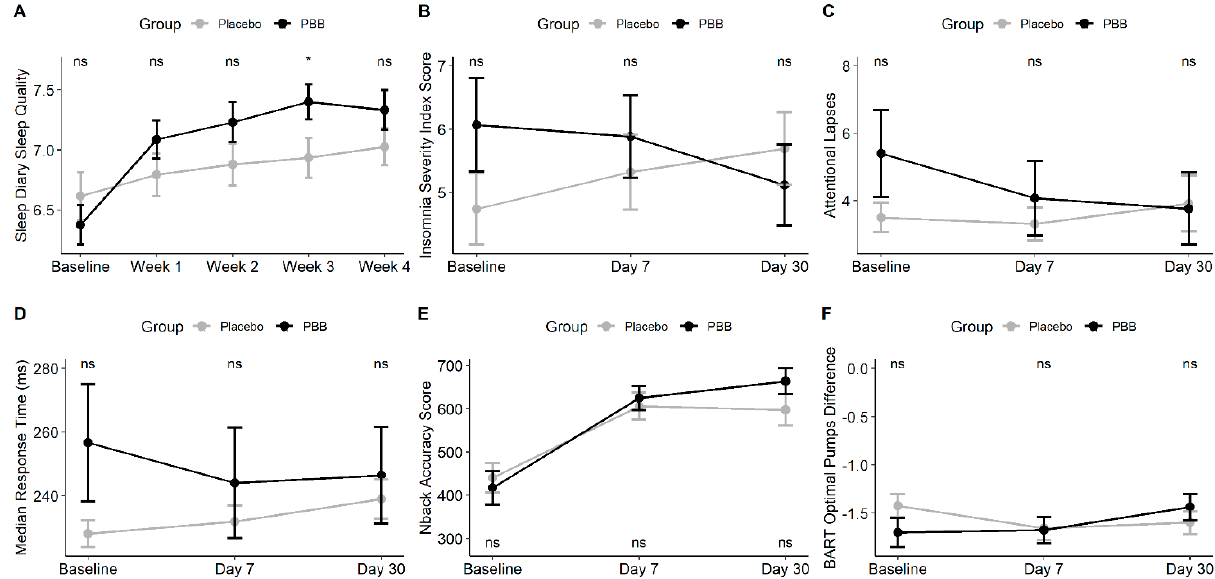
Figure 2. Mean ( ± SE) plots for outcomes with significant group by time effects, including sleep diary sleep quality ( A ), ISI score ( B ), lapses ( C ), PVT median reaction time ( D ), N-back accuracy ( E ), and BART optimal pumps difference ( F ). Tests of significance are between-group t -tests. * p < 0.05. ISI: Insomnia Severity Index, PBB: proprietary blend of botanical extracts, PVT: Psychomotor Vigilance Task, BART: Balloon Analogue Risk